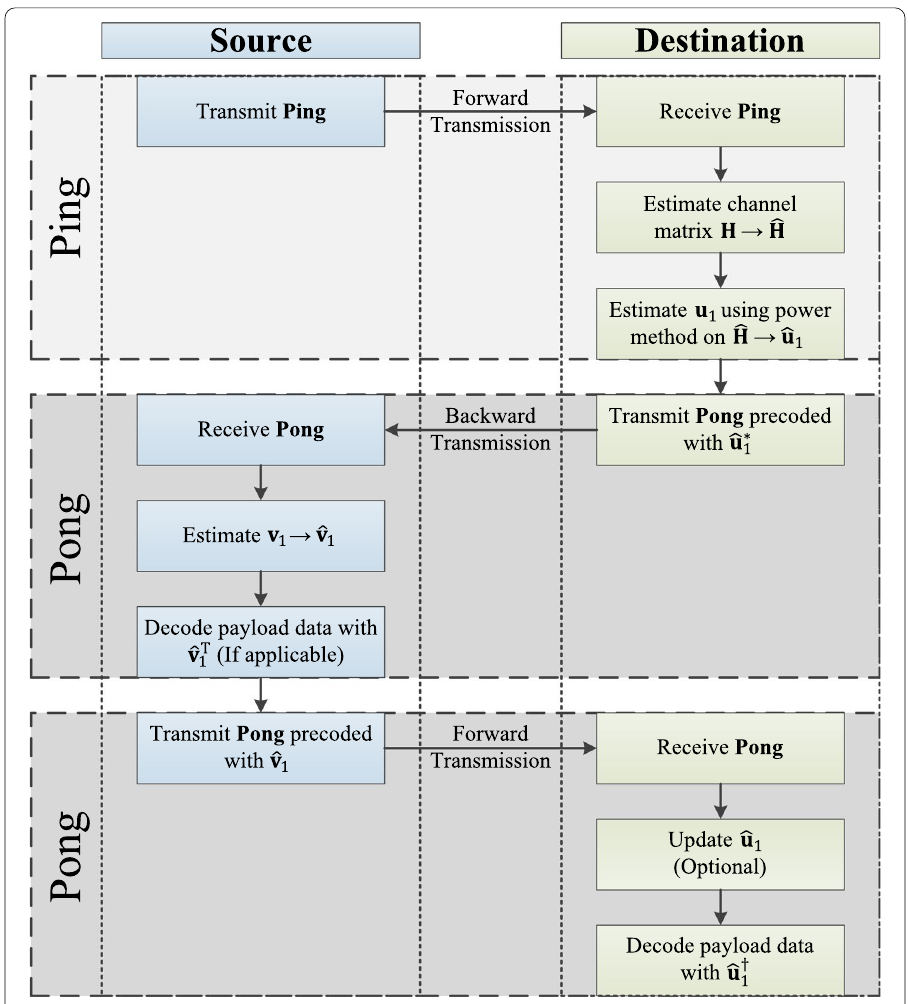
Fig. 2 Summary of the Ping – Pong – Pong steps in each of the two nodes involved in the communication. The left side (blue) shows the steps of a node operating as a source. The right side (green), shows the steps of